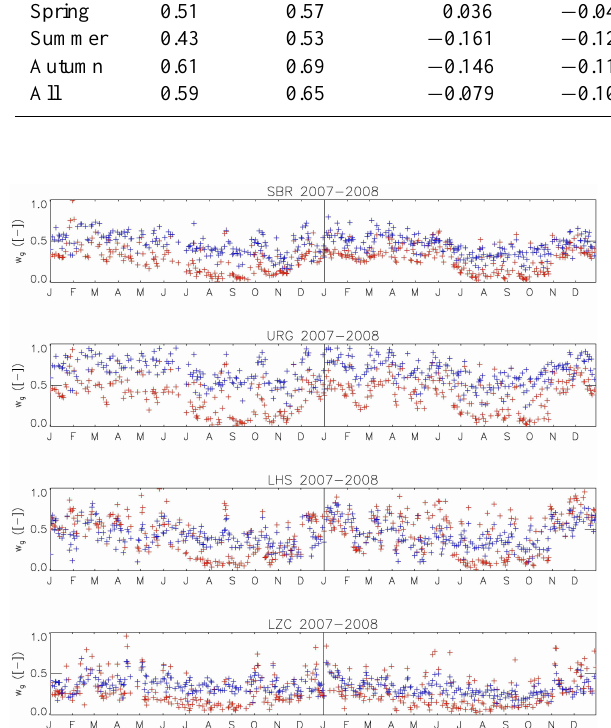
Fig. 4. Comparison between modelled SSM from the SIM model (red crosses) and ASCAT SSM estimates (blue crosses) for four stations of the SMOSMANIA network (Sabres, Urgons, Lahas, and L´ezignan-Corbi`eres – SBR, URG, LHS, LZC, respectively) over a two year period (2007–2008).